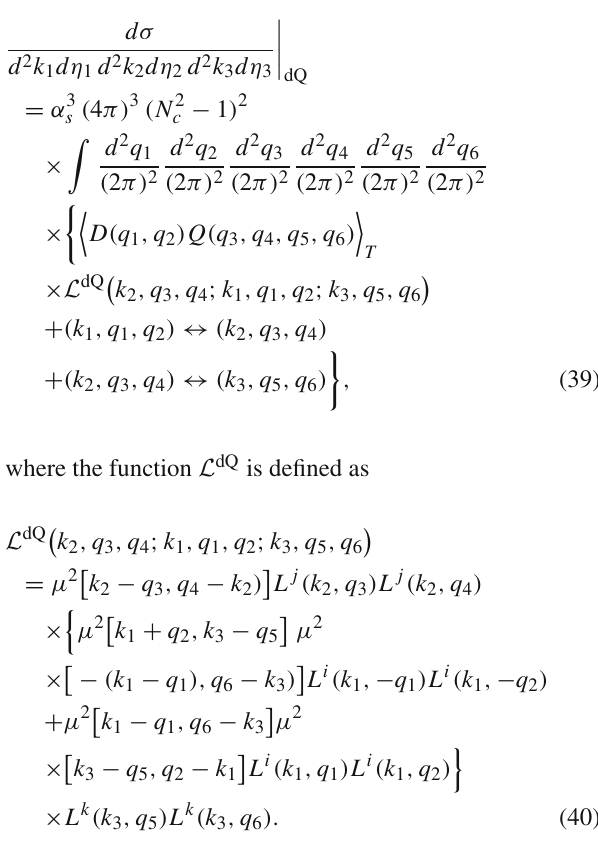
Fig. 8. After contracting the color indexes of these four terms with the Wilson line structure from the target side, we can write the X-contribution to the three-gluon production cross section